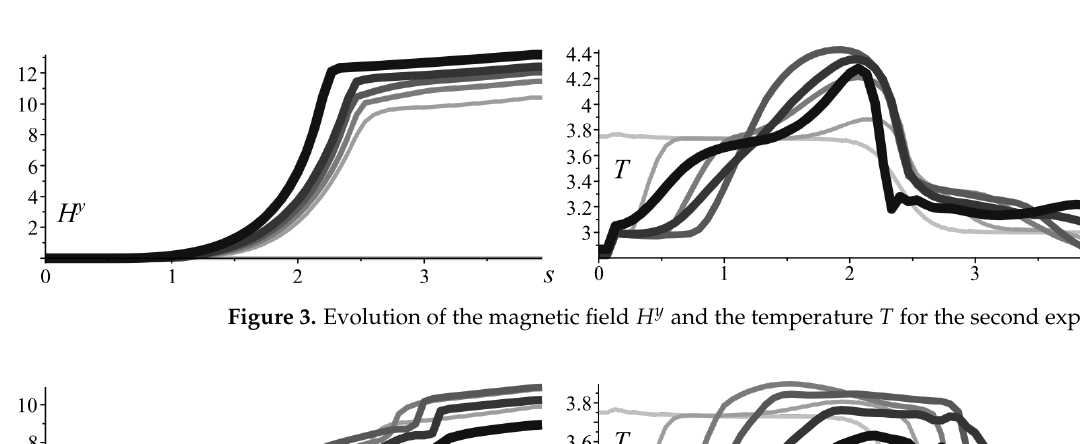
Figure 2. Evolution of the magnetic field H y and the temperature T for the first experiment.